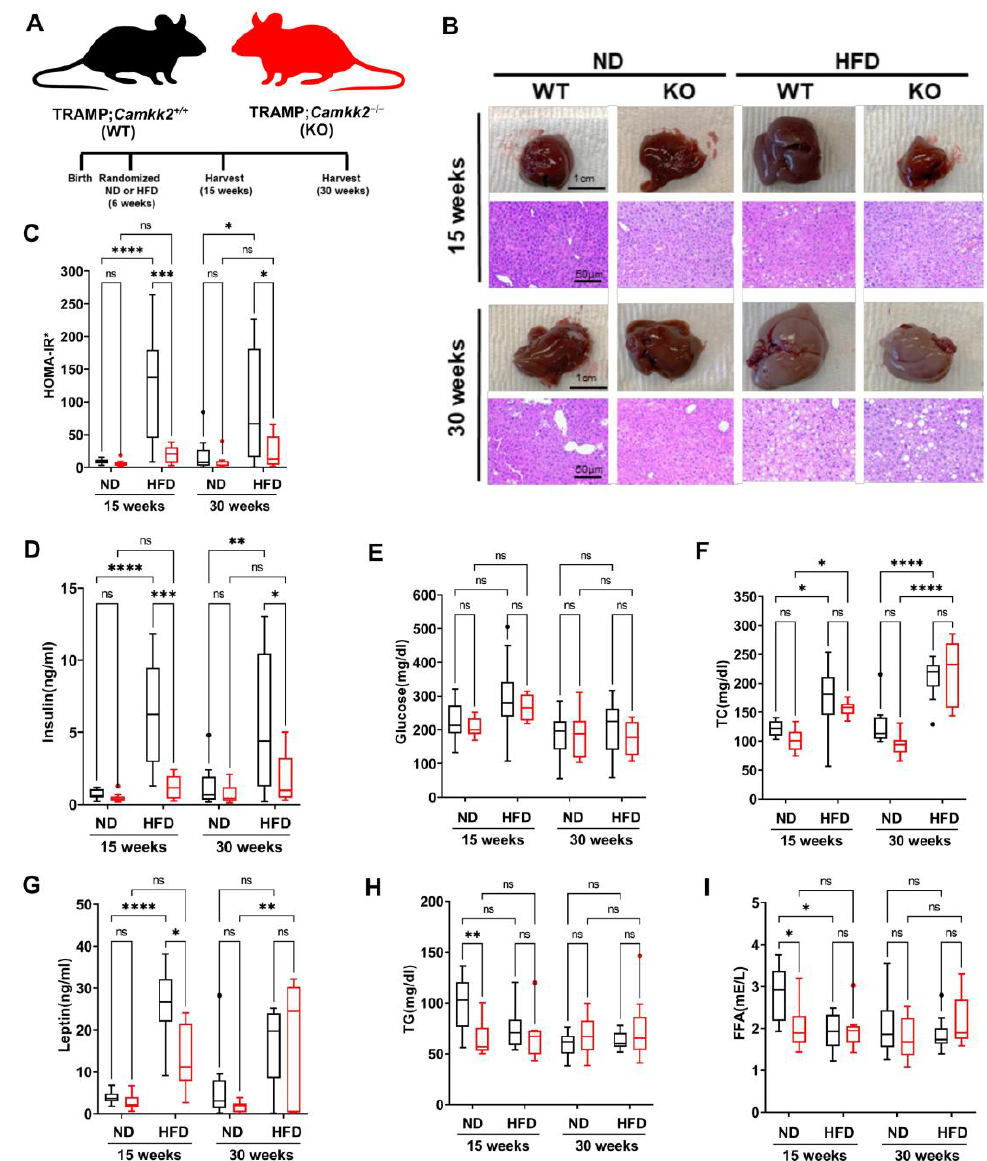
Figure 3. Camkk2 knockout ameliorates high-fat diet (HFD)-induced insulin resistance. ( A ) Schema for mouse experiment in which TRAMP; Camkk2 +/+ (WT) and TRAMP; Camkk2 − / − (KO) mice were fed either a normal (ND) or high fat diet (HFD) (15 weeks ND: WT n = 10, KO n = 10; 15 weeks HFD: WT n = 10, KO n = 8; 30 weeks ND: WT n = 10, KO n = 9; 30 weeks HFD: WT n = 10, KO n = 9). ( B ) Gross morphology and H&E comparison of livers from ND- and HFD-fed TRAMP mice. Raw images and weights of all livers are available in Supplementary File S2. ( C – I ) Plasma analyses of non-fasted mice. ( C ) Calculated HOMA-IR* scores, and measured levels of ( D ) insulin, ( E ) glucose, ( F ) total cholesterol (TC), ( G ) leptin, ( H ) triglycerides (TG), and ( I ) free fatty acids (FFA). * p < 0.05, ** p < 0.01, *** p < 0.001; **** p < 0.0001; Two-way